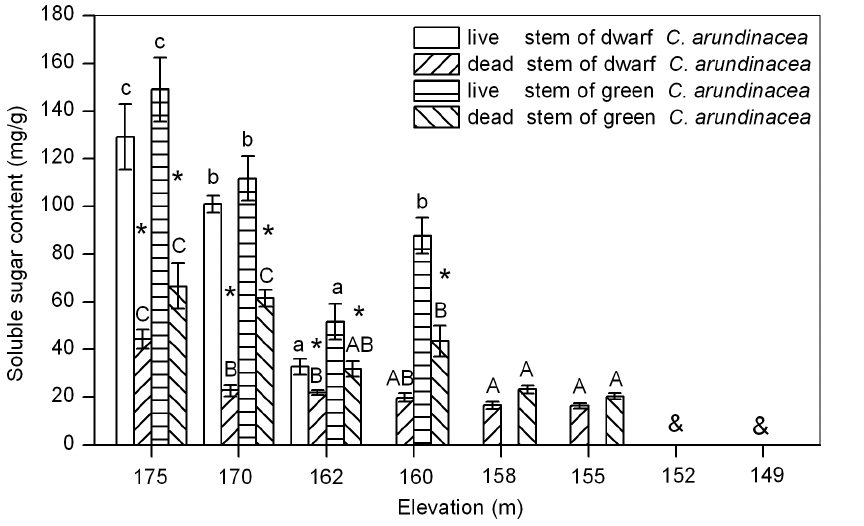
Figure 1. Effects of flooding on soluble sugar content in live stems (LS) and dead stems (DS) of dwarf and green Calamagrostis arundinacea . Values are mean 6 SE based on 3–6 independent assays. Different letters indicate statistical significance ( P , 0.05) according to Duncan’s test, with lowercase for LS and capitals for DS. * indicates that a significant difference occurred between soluble sugar content of LS and DS according to T-test, while & indicates that no samples were available at the elevation.